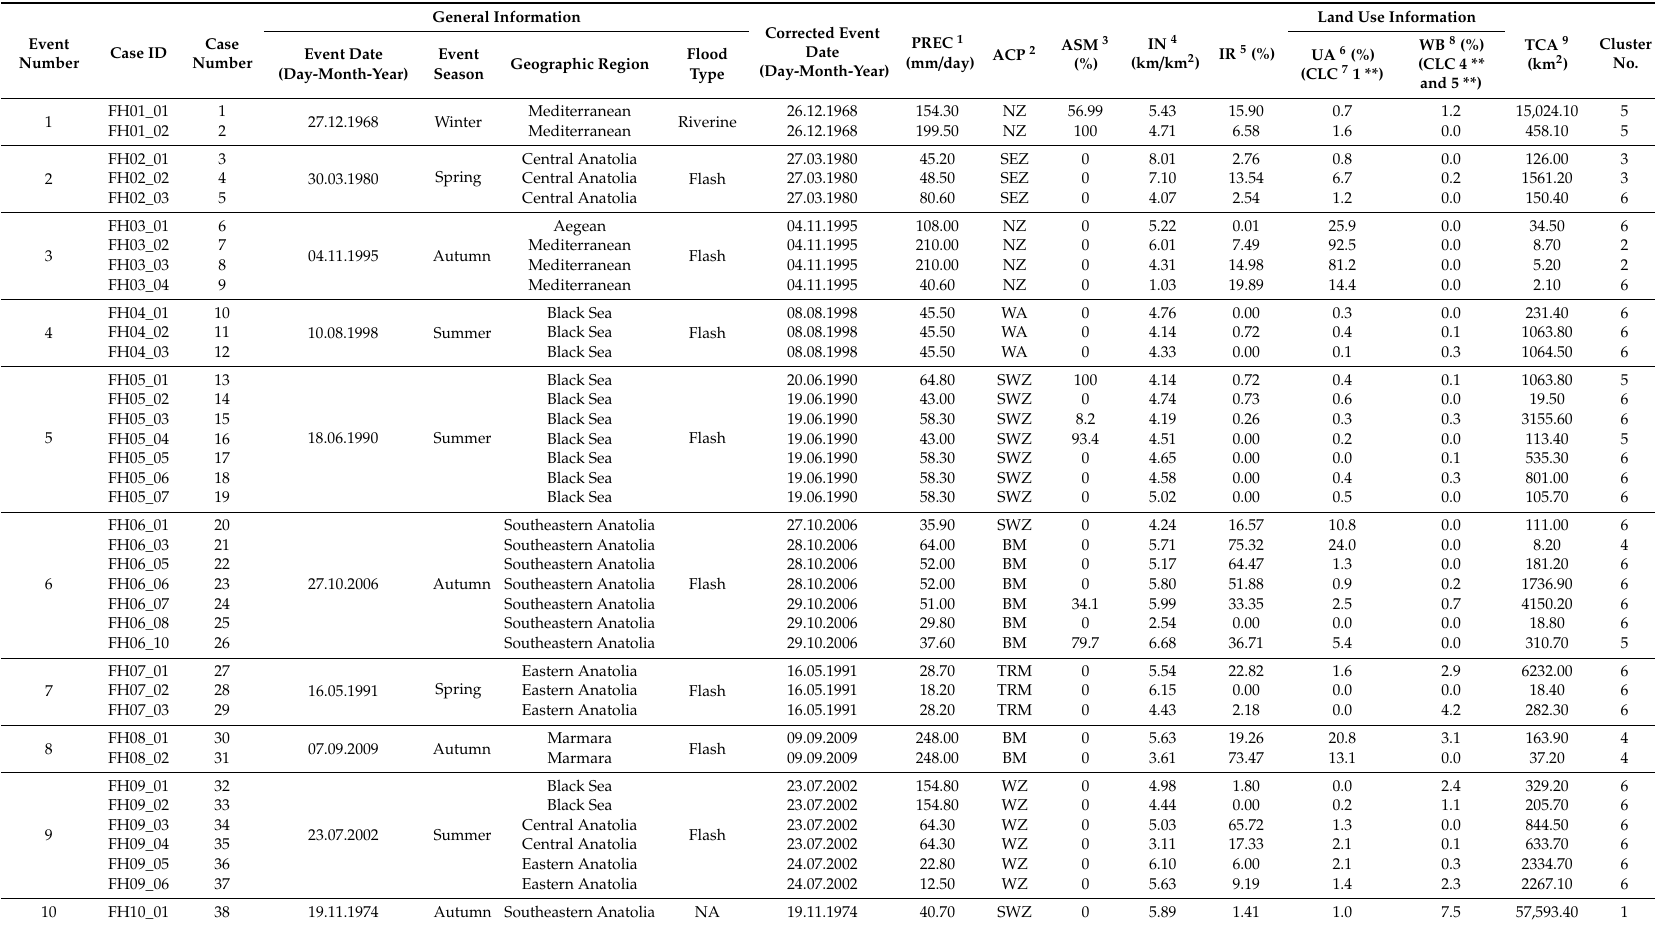
Table A1. Most severe flood events in Turkey (1960–2014) and analyzed flood-triggering